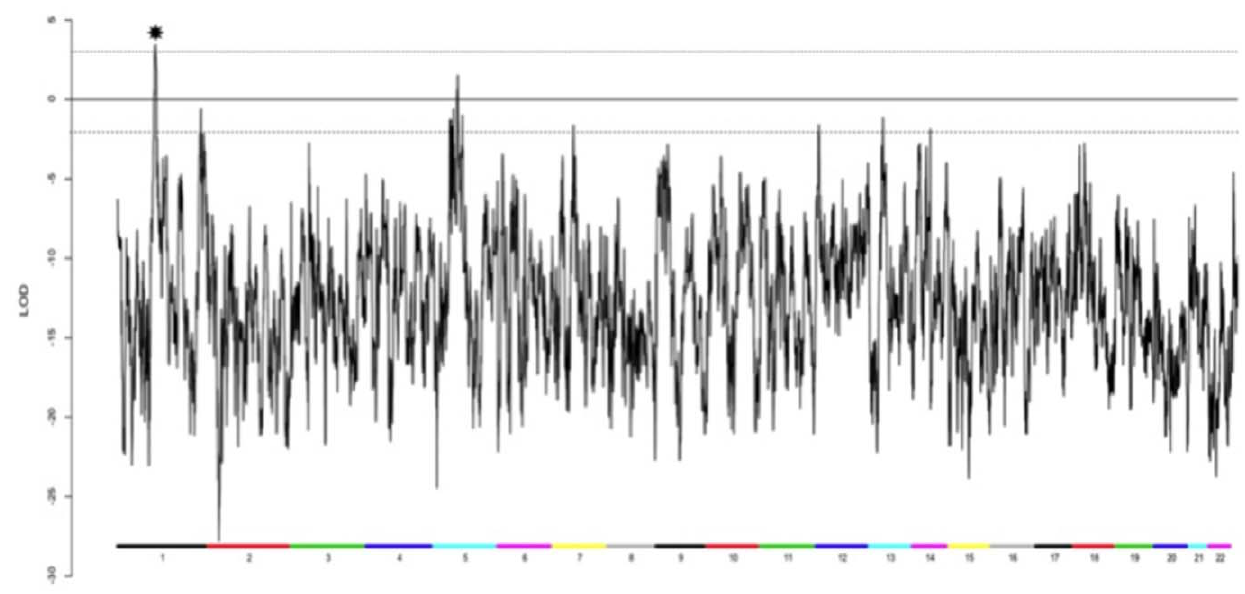
Figure 2. Genome-wide affected only linkage scan in 17 families with 71 individuals. Colored bars at the bottom of the figure label each chromosome. A maximum LOD of 3.45 score was observed at chromosome 1q41-42 (starred). A second region with a positive LOD=1.52 was observed on chromosome 5. LOD scores for the remainder of the genome were negative.